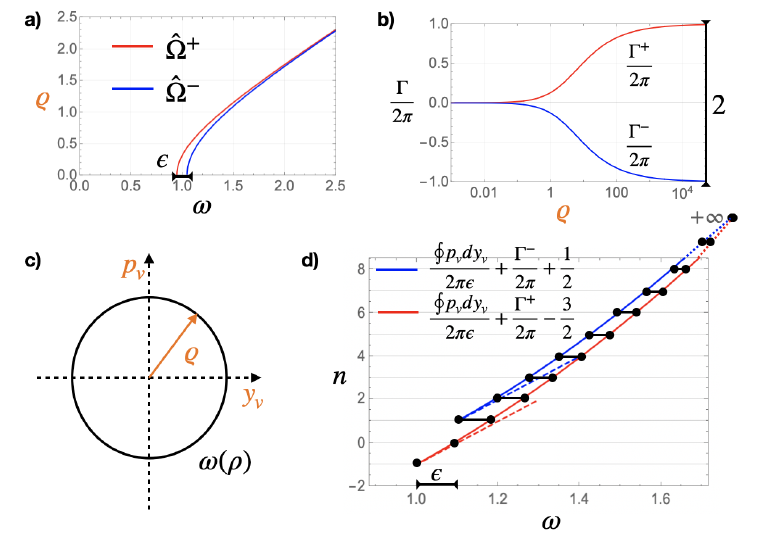
Figure 5: (a) Variations of the circular trajectory radius ϱ as a function of fre- ) . (b) Variation of the Berry flux across the area quency ω in phase space ( y , p v v delimited by a circular ray trajectory having a radius ϱ . (c) A circular trajectory in phase space. (d) Quantization condition for shallow water waves in the semi- classical limit, as expressed in (71)-(74). Red and blue curves are associated respec- tively with operators ˆ Ω + and ˆ Ω − . The sign ± is due to the definition n ± = 1 Dashed lines correspond to explicit computations performed in the limit ε → 0 at finite n , see Appendix